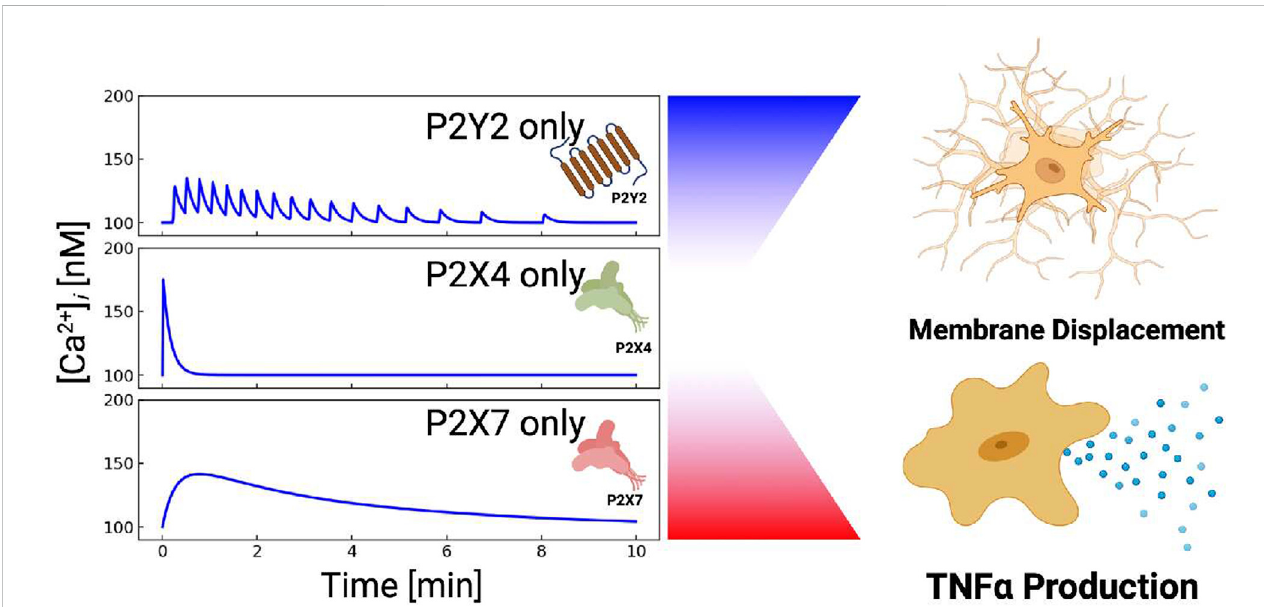
FIGURE 10 P2X and P2Y receptors can be combined to control different cellular outcomes. P2X4-induced Ca 2+ entry manifests a sharp but brief rise in cytosolic Ca 2+ .P2X7-mediatedCa 2+ entryresultsinbluntandprolongedCa 2+ elevations. P 2 Y -classreceptors(mainly P 2 Y 2)yieldoscillatoryCa 2+ transients,while P 2 Y 12 (not shown) promotes membrane